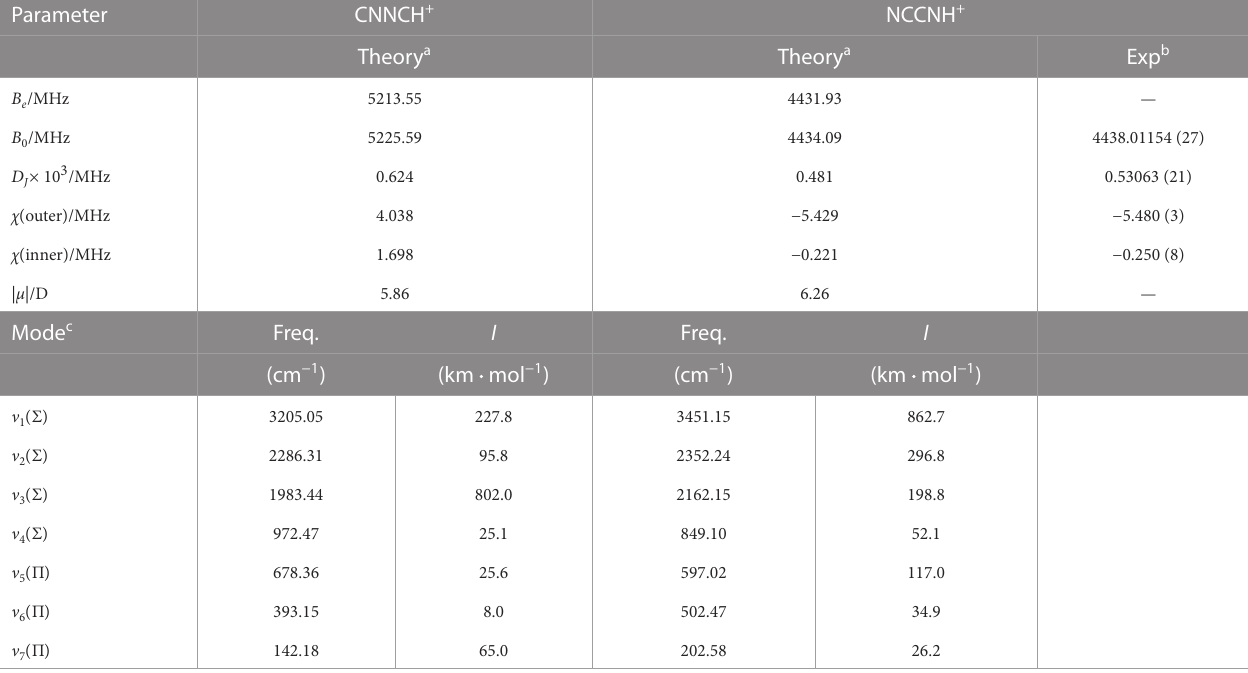
TABLE4 RotationalparametersandfundamentalvibrationalfrequenciesofCNNCH + andNCCNH + . Parameter